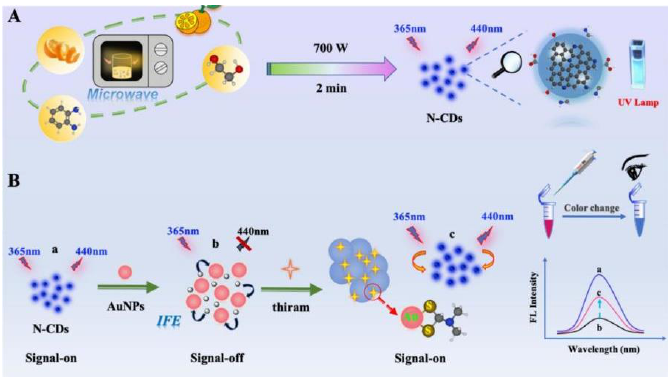
Figure 8. Schematic illustration of an AuNPs and N-CDs based fluorescent “on-off-on” nanosensor for thiram detection. ( A ). the preparation process of N-CDs. ( B ). the detection process of nanosensor. Adapted with permission from. Fu et al., 2022, copyright 2022. Reproduced with permission from Elsevier [57].